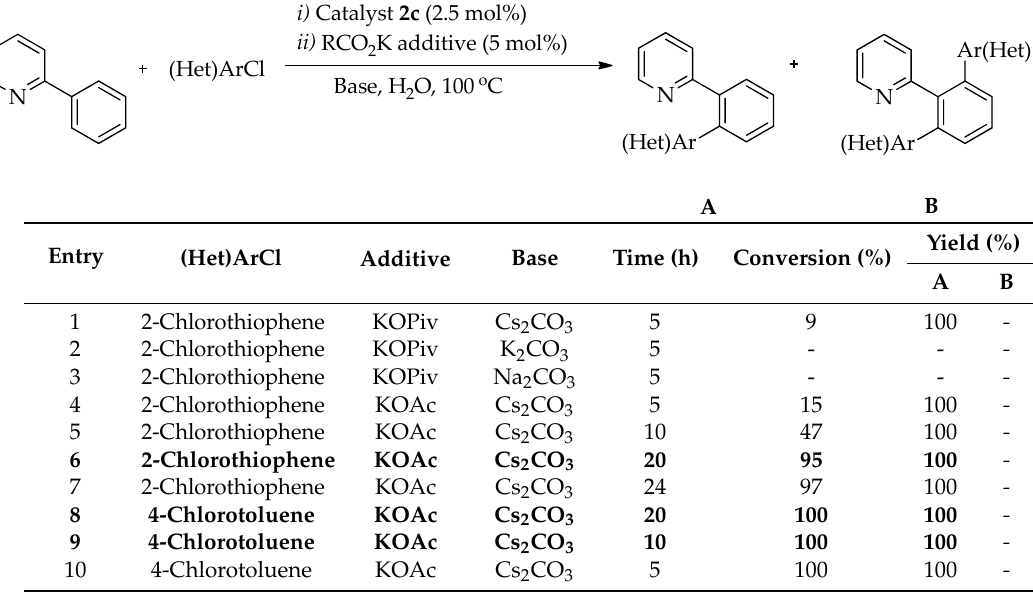
Molecules 2018 , 23 , x FOR PEER REVIEW Table 3. Arylation of 2-phenylpyridine with (hetero)aryl chlorides: A search for optimal catalytic conditions a .